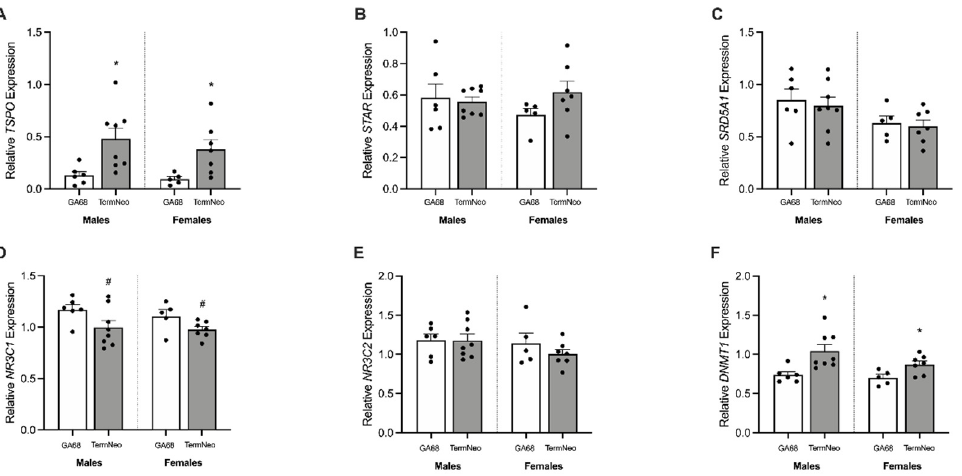
Figure 6. Relative mRNA expression for steroid synthesis and receptor markers, and DNA methyl- transferase enzyme in the hippocampus of fetal GA68 (white; males n = 6, females n = 5) and term neonates (grey; males n = 8, females n = 7). ( A ) TSPO , ( B ) STAR , ( C ) SRD5A1 , ( D ) NR3C1 , ( E ) NR3C2 , and ( F ) DNMT1 . Data presented as means ± SEM with * indicating significance at p < 0.05, and # representing a non-significant trend.